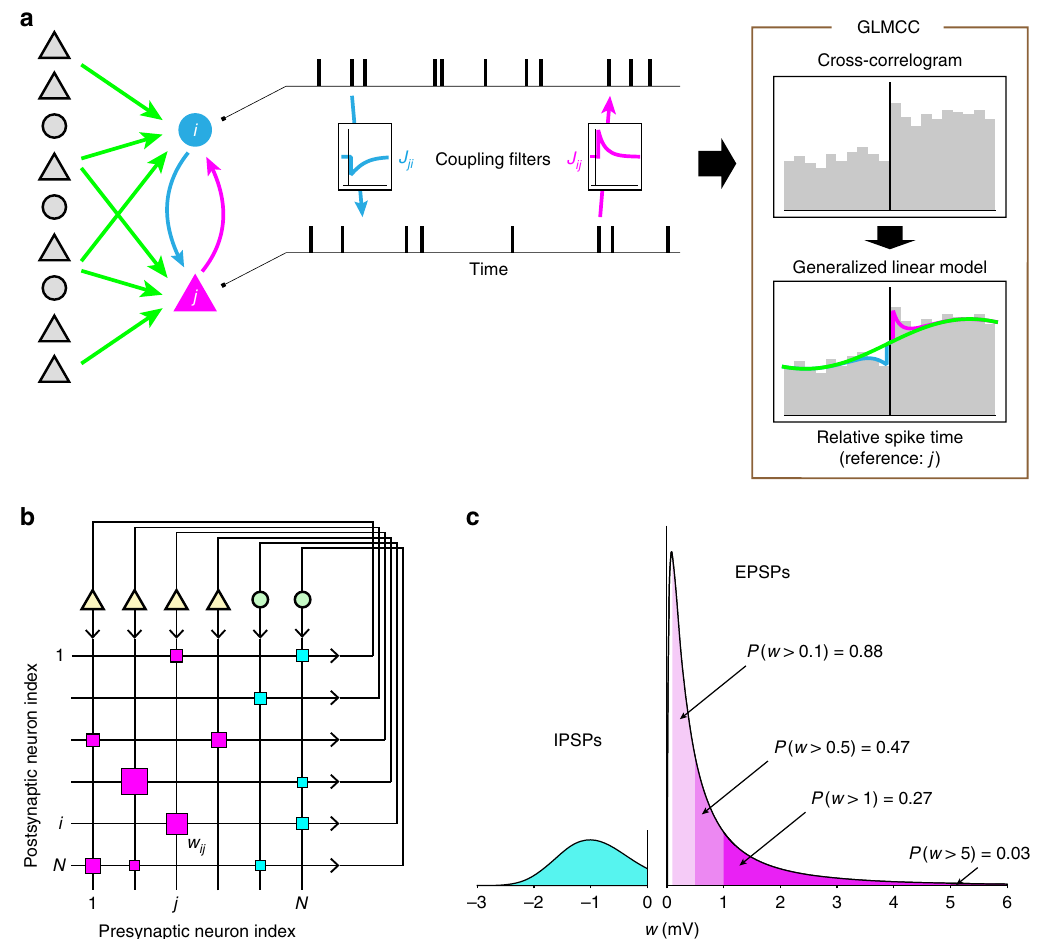
Fig. 1 Estimating neuronal connections. a Connectivity between neurons is estimated by fi tting a generalized linear model (GLM) to the cross-correlation (CC). J ij represents a coupling from the j -th neuron to the i -th neuron. Excitatory and inhibitory neurons are depicted as triangles and circles, and their synaptic connections are colored magenta and cyan, respectively. Surrounding neurons may induce large-scale fl uctuations in the CC (light green line). b Neuronal connectivity is visualized by the Hinton diagram, in which excitatory and inhibitory connections are represented, respectively by magenta and cyan squares of the sizes (area) proportional to the postsynaptic potential (PSP) w ij . c Distributions of excitatory postsynaptic potentials (EPSPs) and inhibitory postsynaptic potentials (IPSPs) of a simulated